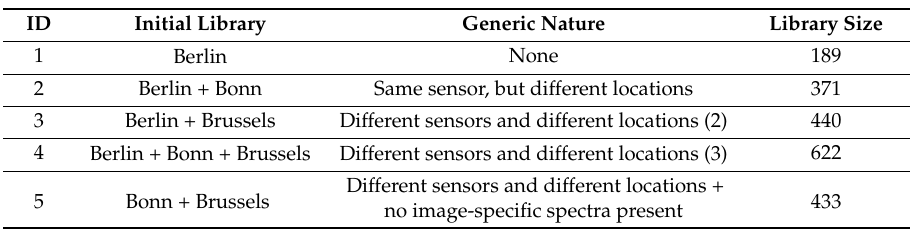
Table 3. Experiments run on the Berlin dataset, stating the composition of the initial library, its generic nature and library size.